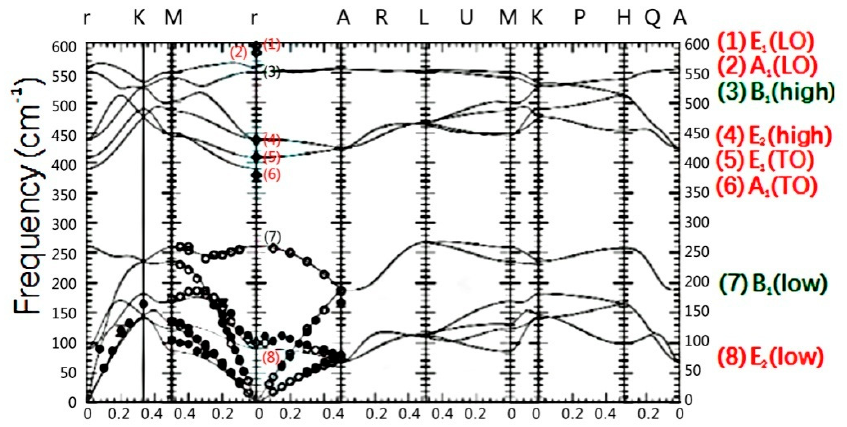
Figure 6. Phonon dispersion relationship of wurtzite zinc oxide are calculatedat Γ point in the specified